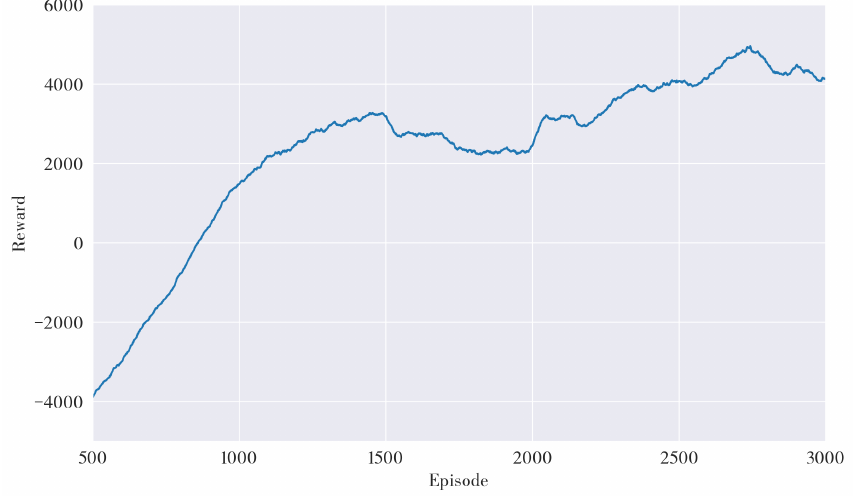
Figure 4. Average Cumulative Reward of DDPG